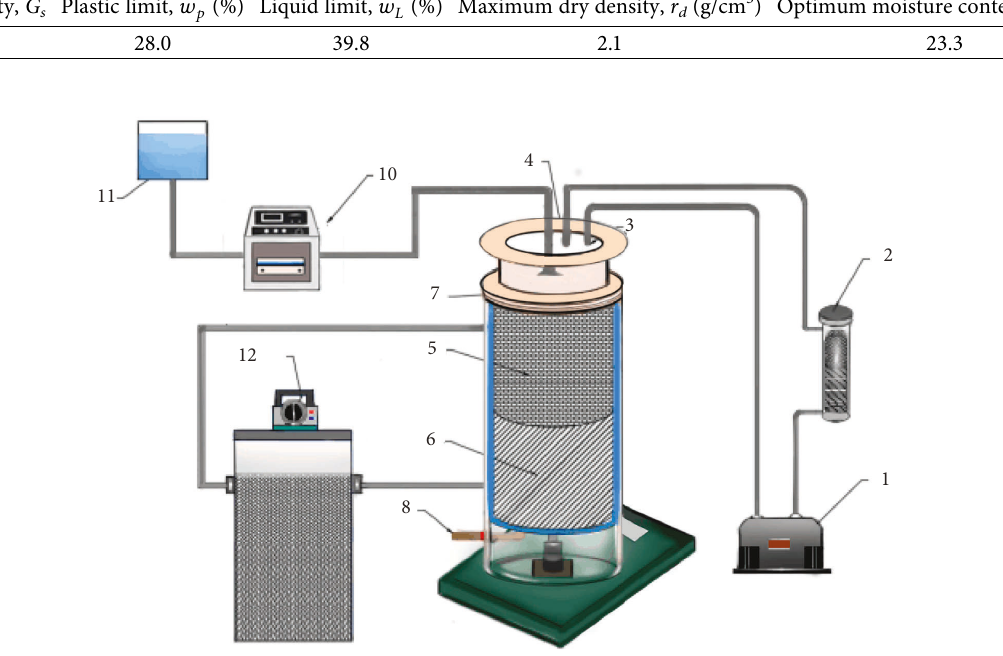
Figure 2: Schematic of a test